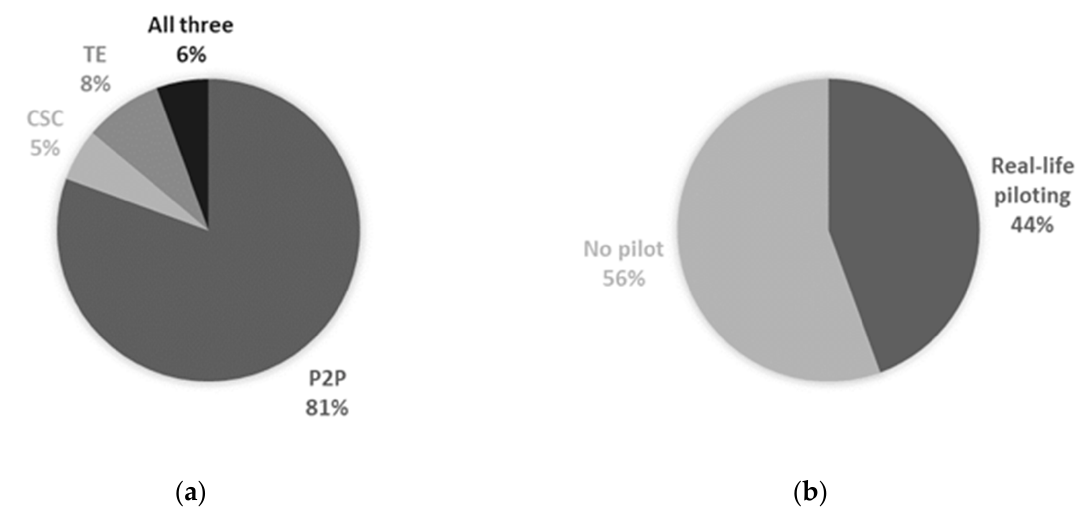
Figure 3. ( a ) Proportion of articles about P2P, CSC, TE or all the models; ( b ) proportion of articles involving real-world piloting.